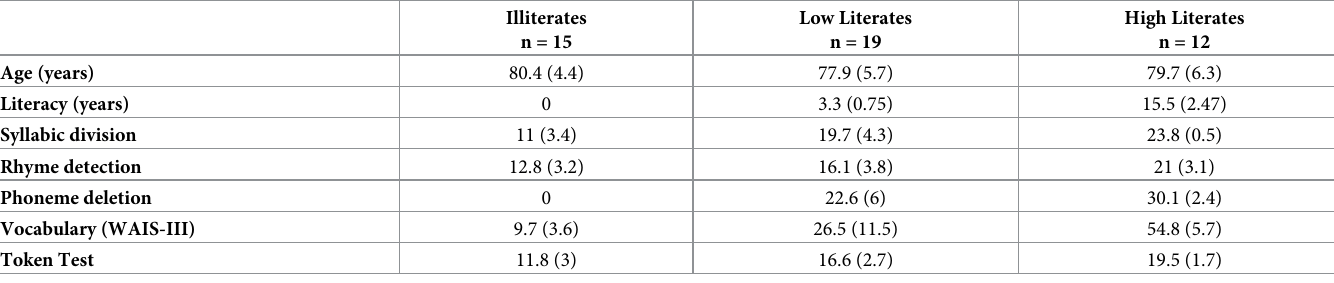
Table 1. Participant characteristics a